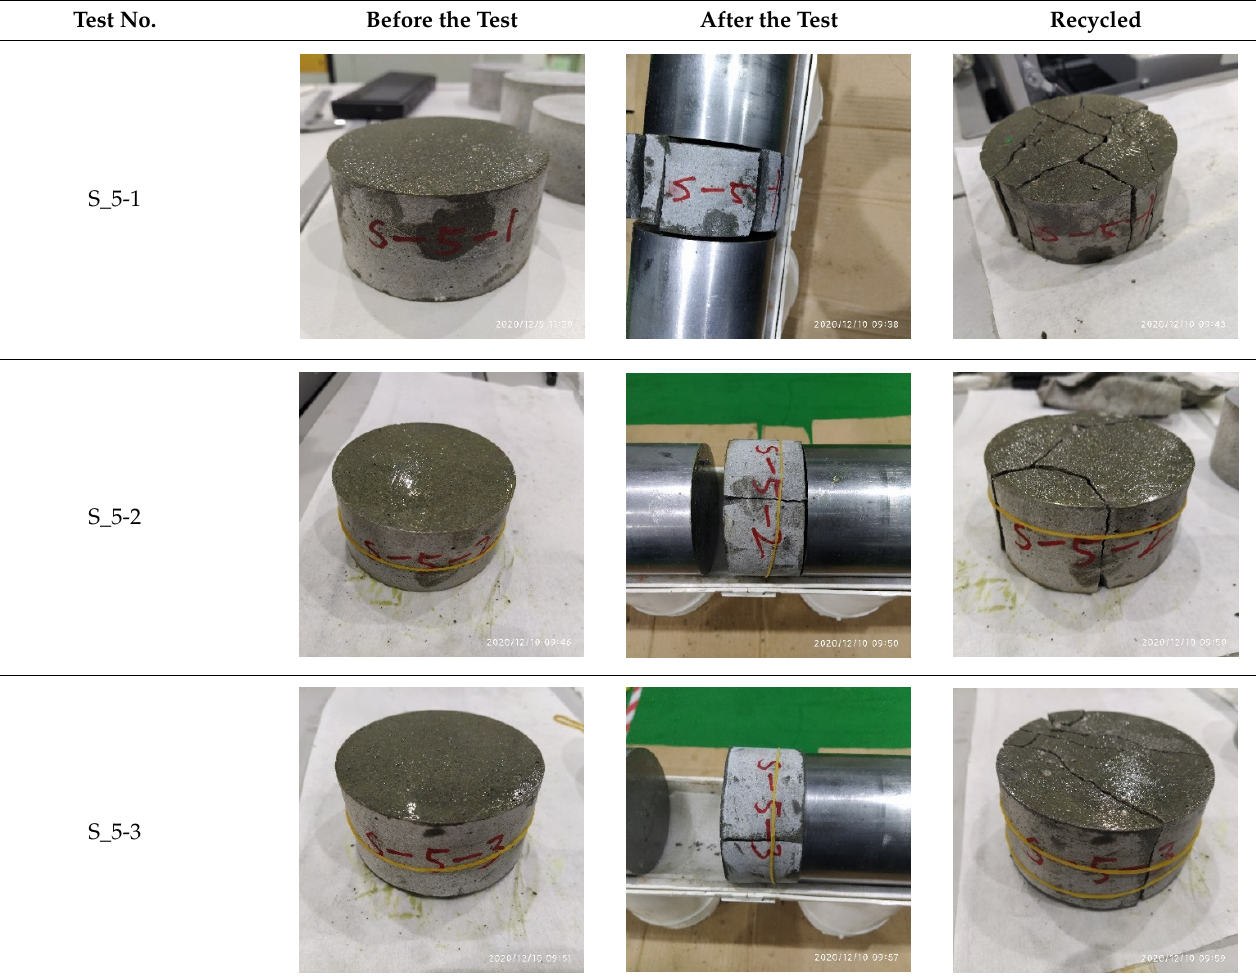
Table 3. Test results at an impact velocity of 5 m/s.